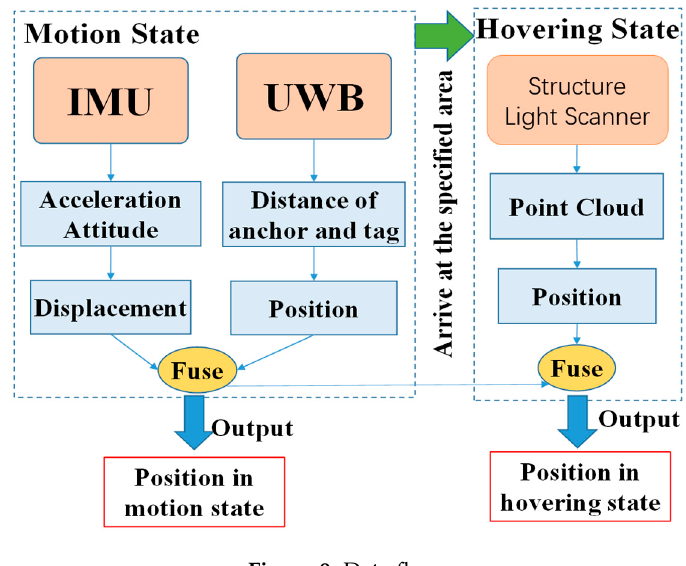
Figure 9. Data Figure 9. Data flow.